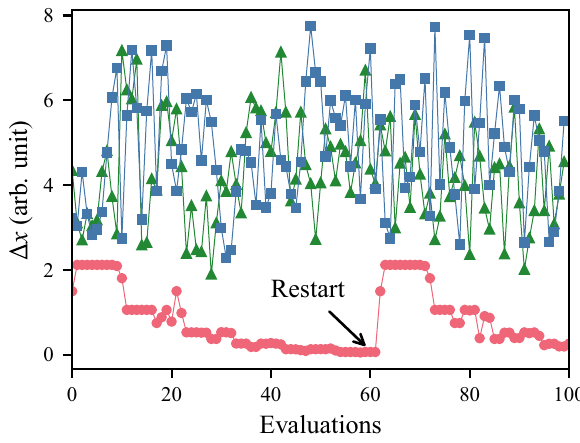
FIG. 7. Convergence behavior of BO with UCB (green, triangle) and EI (blue, square) acquisition functions and Nelder-Mead (red, circle) on the nine-dimensional problem showing the distance Δ x between two consecutive sampled points in the scaled parameter space. Due to the noisy evaluation of the objective function, Nelder-Mead optimizes mostly locally and often needs to be restarted, whereas BO optimizes globally and does not require a restart.